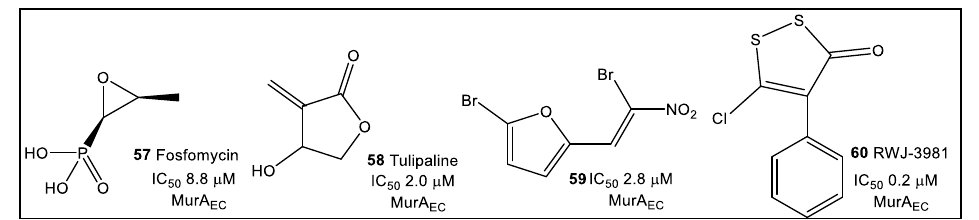
Figure 10. Illustrative examples of small heterocyclic inhibitors of MurA EC. They inhibit enzyme activity by forming a covalent bond with cysteine in the enzyme active site.